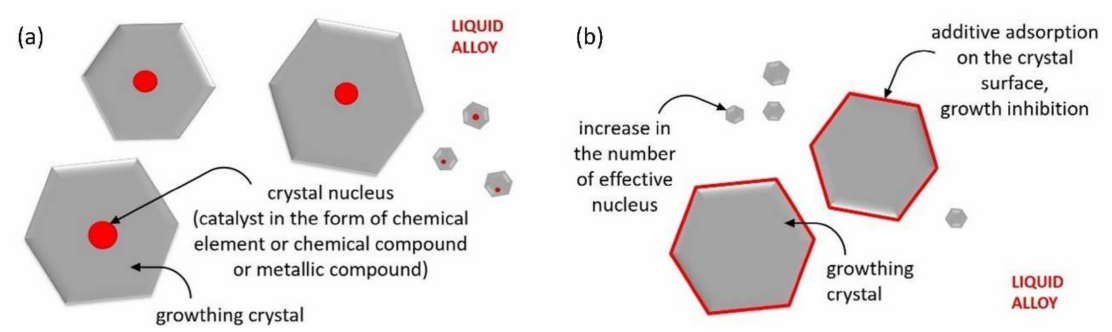
Figure 1. Schematic diagram of the effect of ( a ) nucleogenic elements on the growth of crystals [1]; ( b ) surface-active elements on nucleation and the growth of